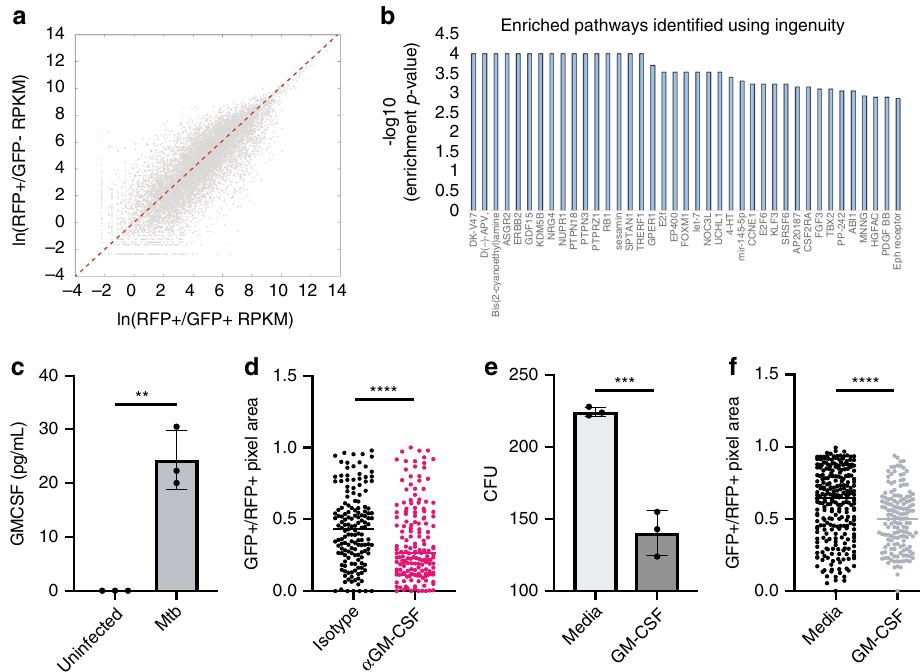
Fig. 2 Transcriptional pro fi ling reveals GM-CSF as critical regulator of macrophage control of Mtb. a Scatter plots comparing gene expression between RFP + /GFP- macrophages to RFP + /GFP + macrophages from the same culture. b Bar graph summarizing results of pathway analysis of differentially expressed genes in a using Ingenuity Pathway Analysis identifying the CSF2RA (GM-CSF signaling) pathway as enriched in differentially expressed genes. c Extracellular GM-CSF was measured and compared between paired Mtb-only and uninfected cultures at 24 h post-Mtb infection. Error bars represent standard deviation of the technical replicates. Comparisons made using a two-tailed t-test. Representative of three donors. d Mtb-infected macrophages were scored 4 days post-infection based on the percentage of transcriptional activity following pre-treatment with anti-GM-CSF antibody or isotype control. Dots represent data from an individual macrophage. Black lines represent the median. Comparisons made using the Mann – Whitney test. Representative of three donors. e Measurements of bacterial survival after GM-CSF treatment using colony-forming units. Error bars represent standard error from three technical replicates. Representative of six donors. Comparisons made using a two-tailed t-test. f Mtb-infected macrophages were scored 4 days post-infection based on the percentage of transcriptional activity of the untreated or GM-CSF treated macrophages. Black lines represent the median. Dots represent data from an individual macrophage. Comparisons made using the Mann – Whitney test. Representative of six donors. (** p < 0.01, *** p < 0.001, **** p < 0.0001). Source data are provided as a Source Data fi